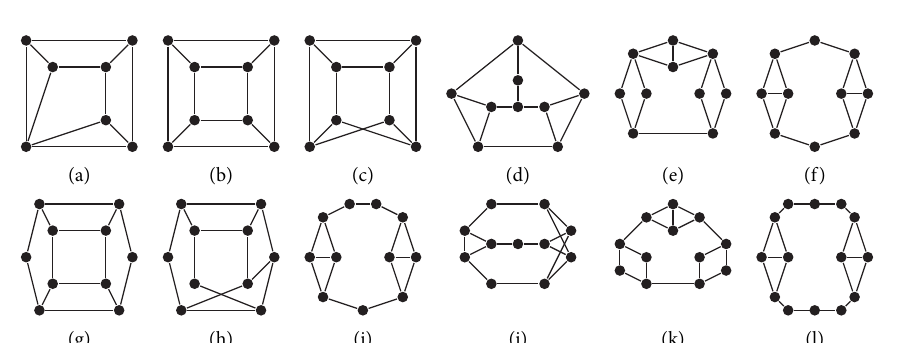
. (b) G 1 . (c) G 2 . (d) G . (e) G 1 . (f) G 2 . (g) G 3 . 7 9 8 8 10 10 10